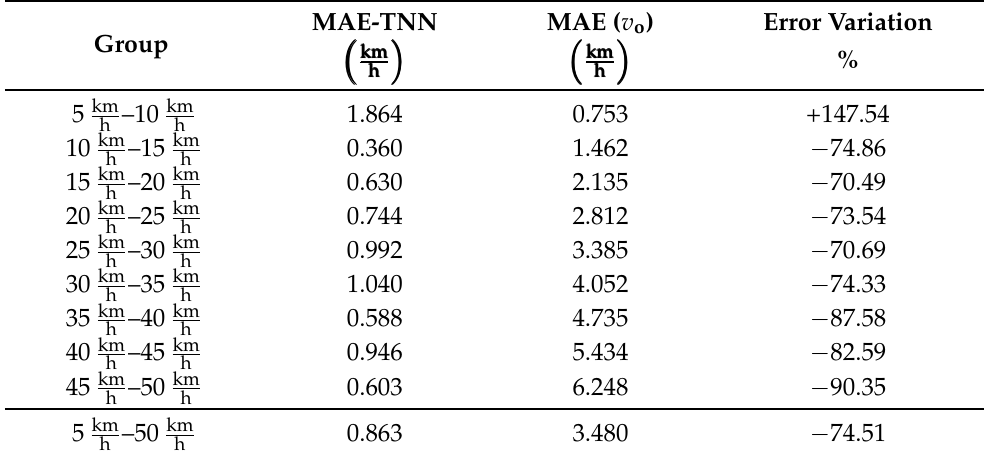
Table 6. MAE for the OBD vs. reference sensor comparison and the MAE for the inference of the TNN vs. reference sensor comparison. Database size: